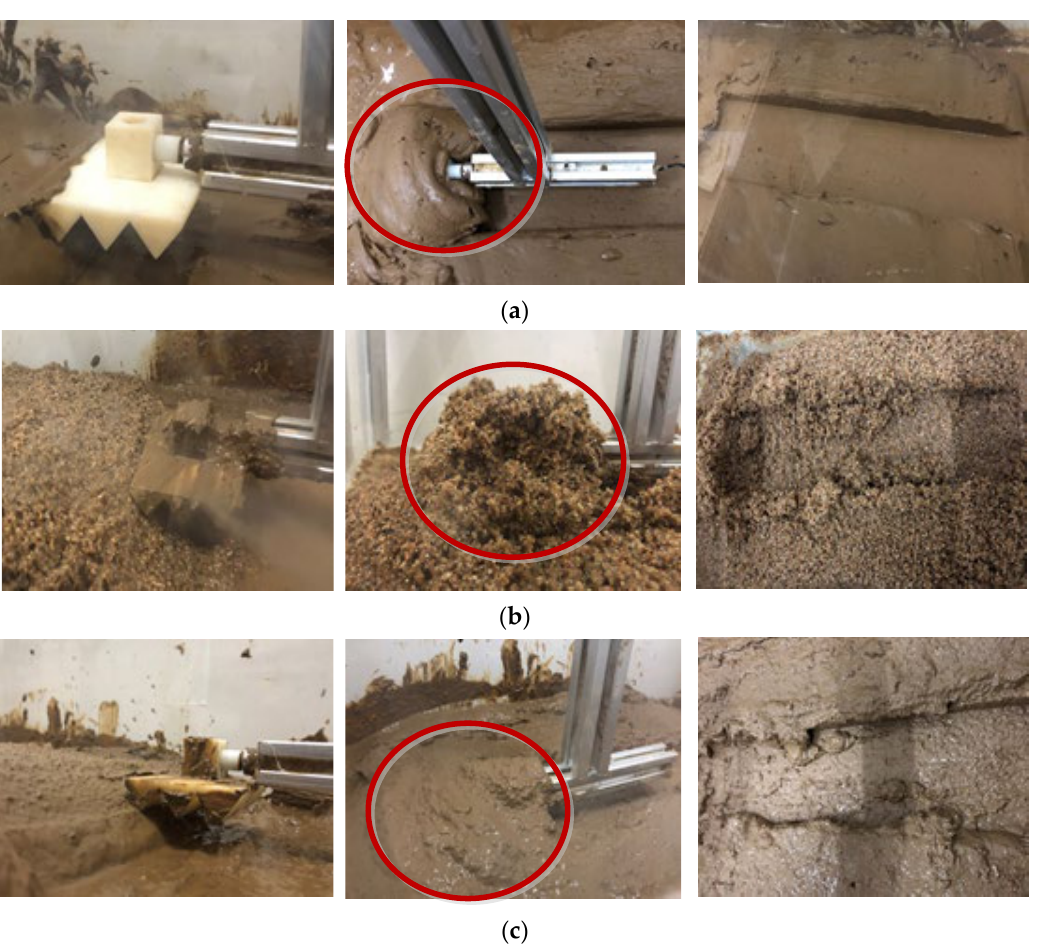
Figure 7. Shear stress–displacement test. ( a ) Shear stress–displacement test of clay. ( b ) Shear stress–displacement test of sand. ( c ) Shear stress–displacement test of mixed soil 2#.